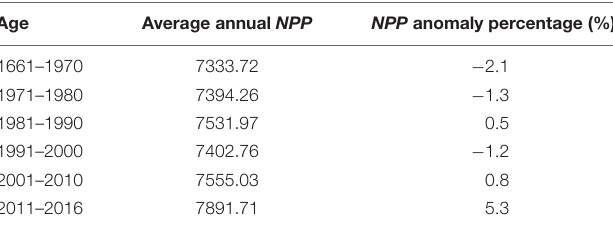
temperature change on the pasture productivity was greater than that of precipitation in the